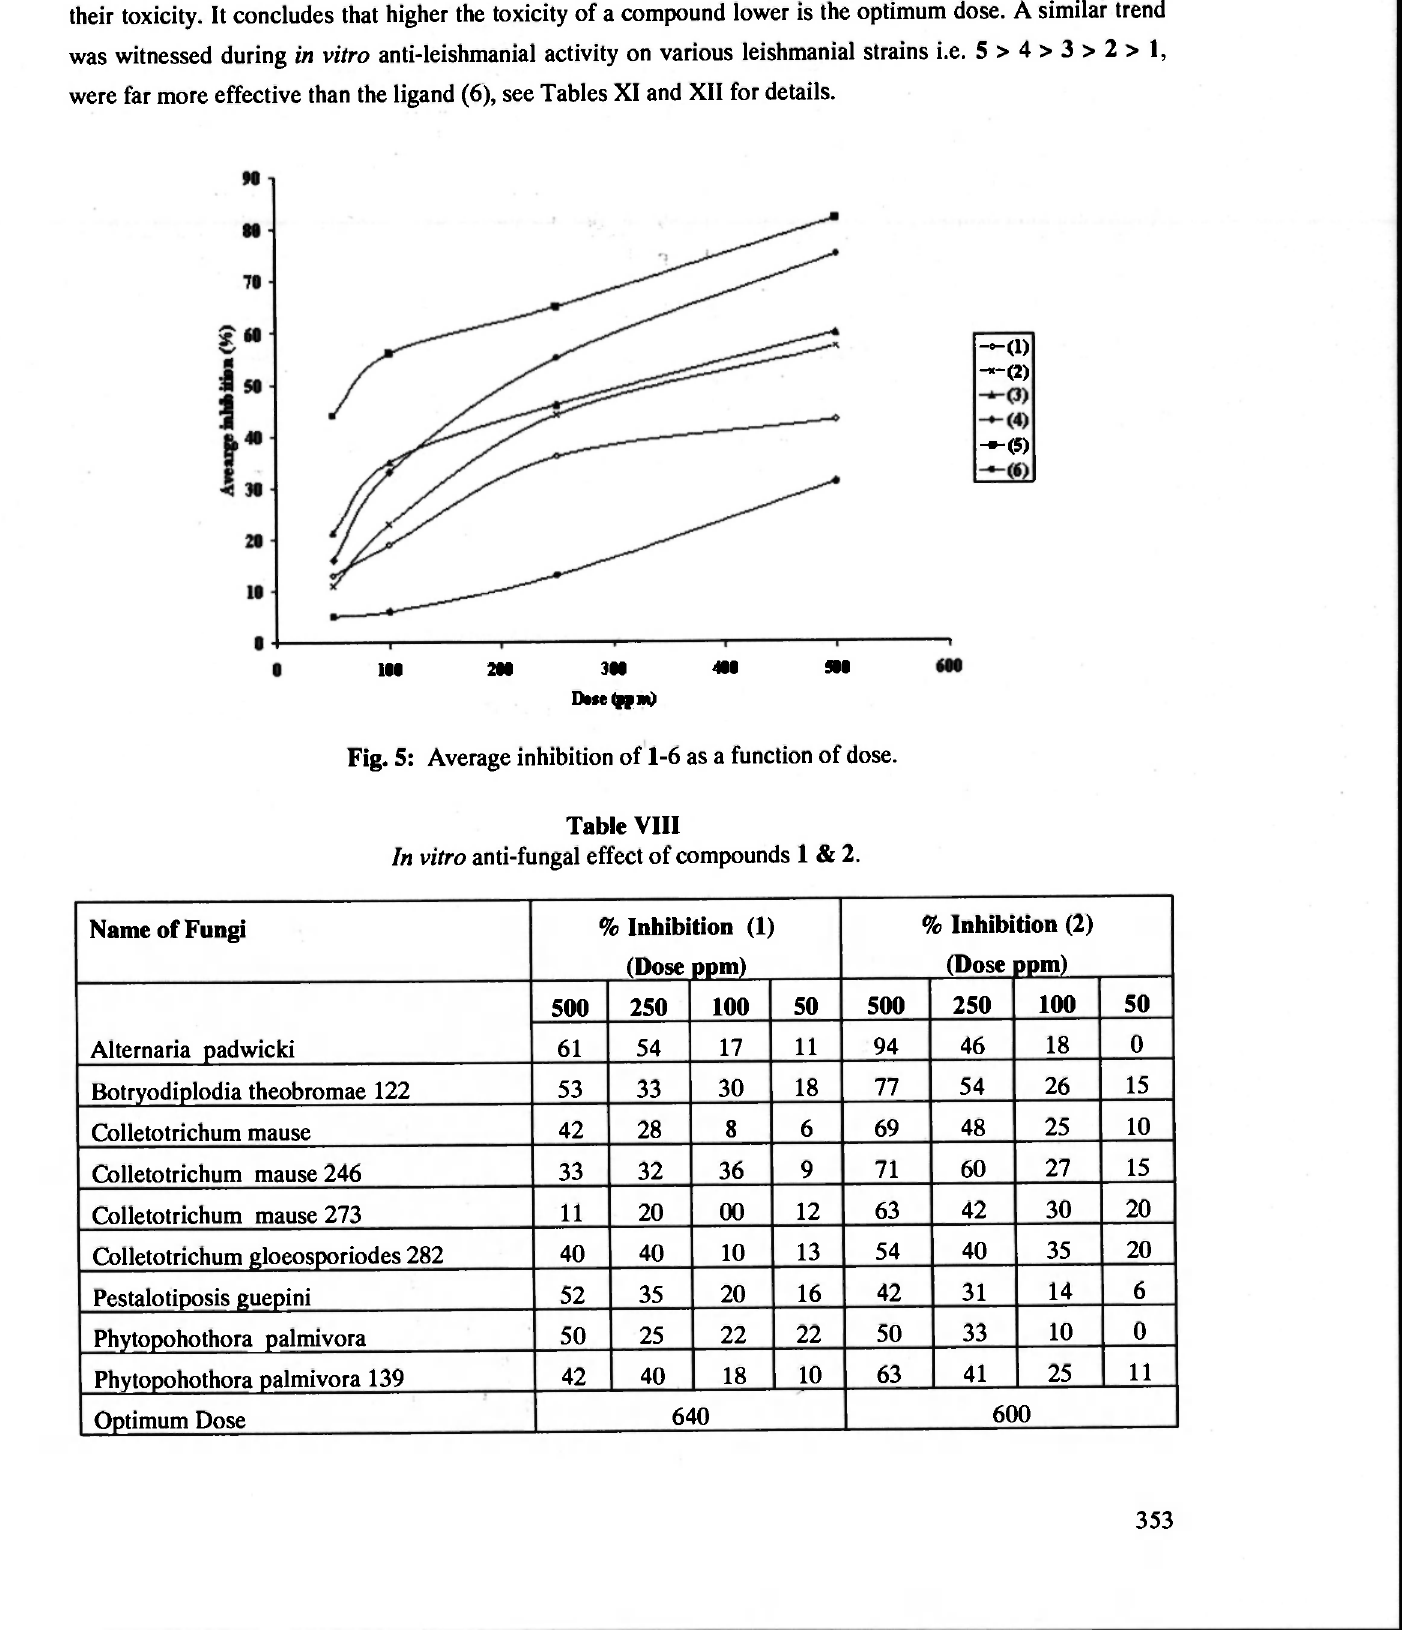
Fig. 5: Average inhibition of 1-6 as a function of dose.